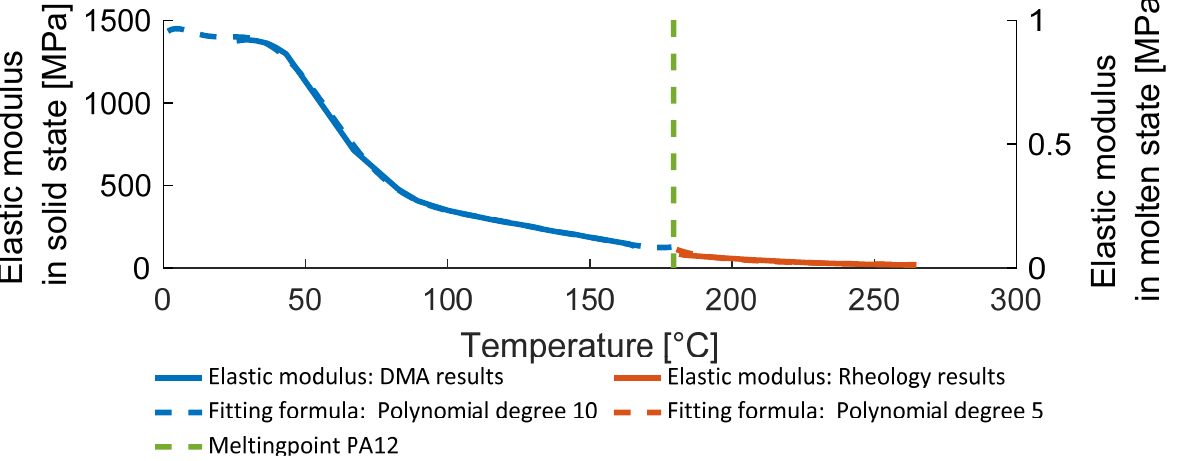
Figure 4. Measured and fit PA12 elastic modulus in solid and molten state.